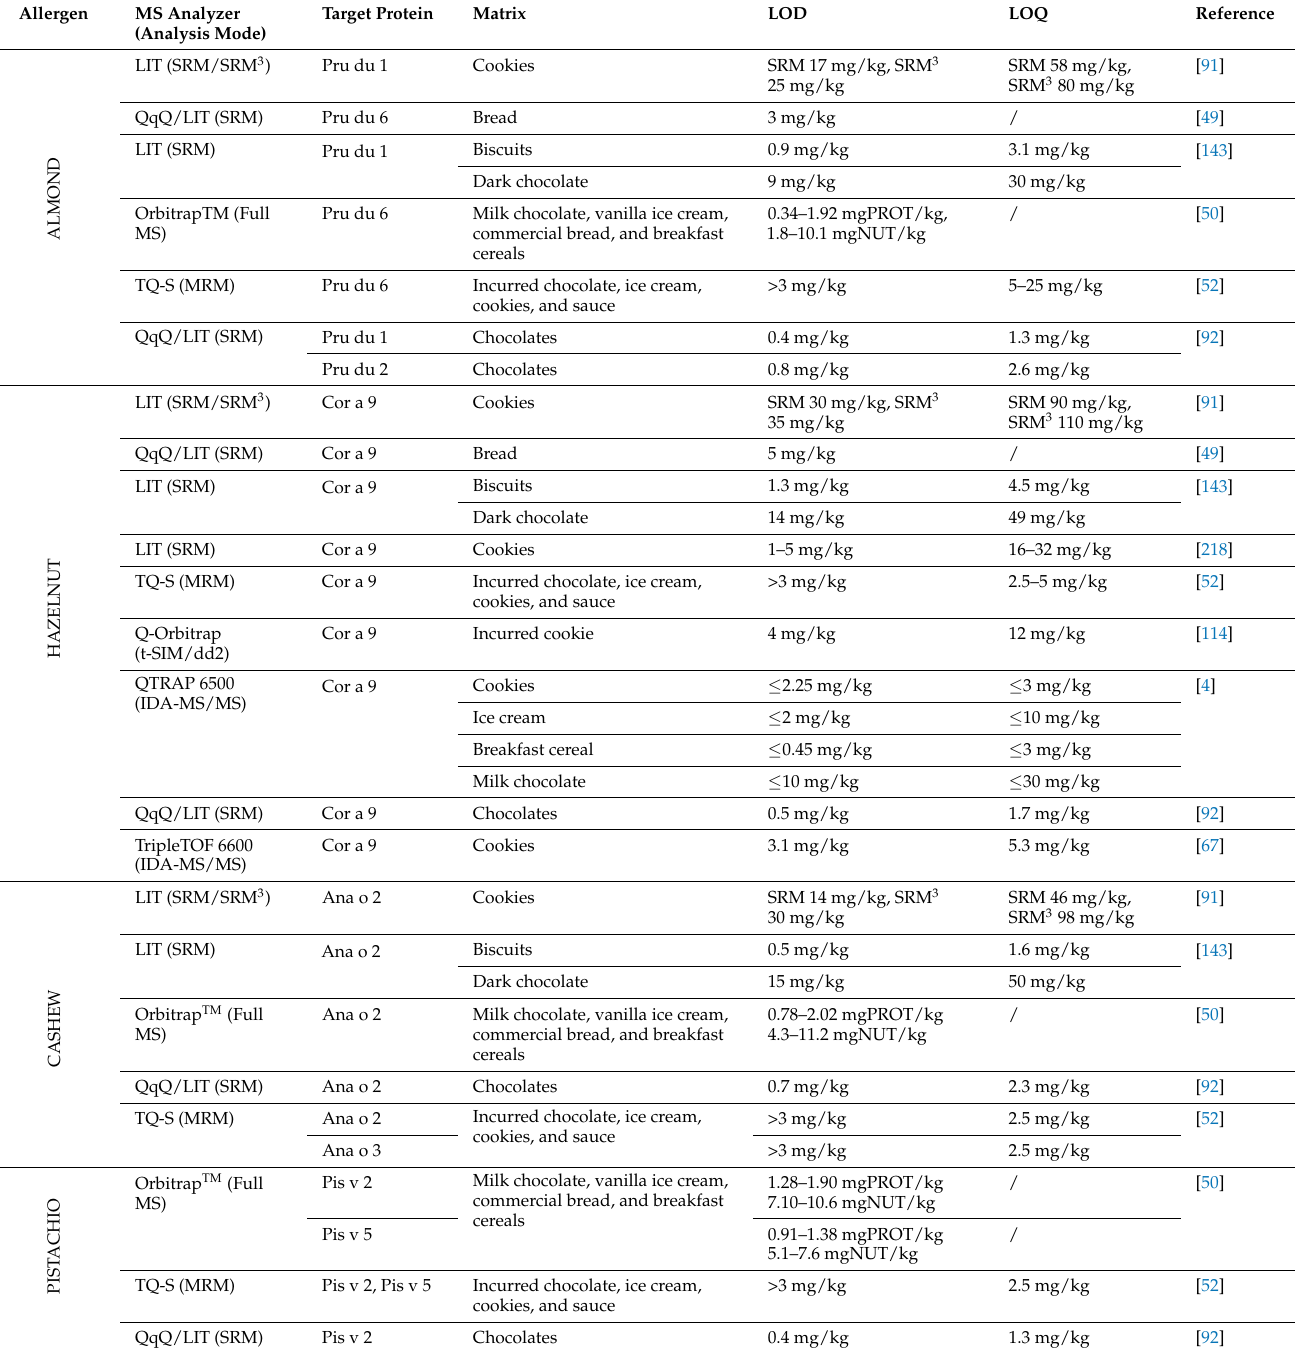
Table 3. Overview on the most recent LC-MS methods developed for nuts and peanuts quantification in food